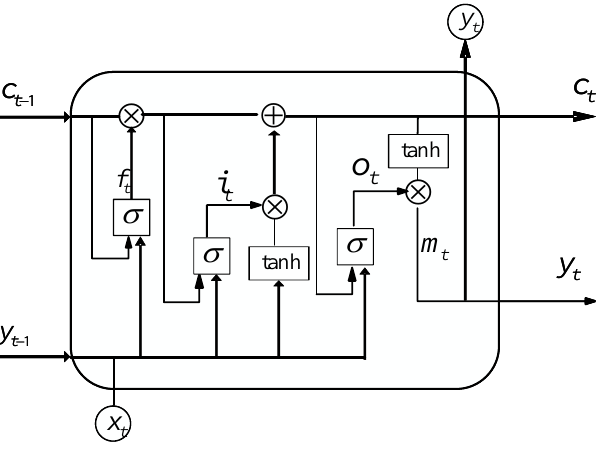
Figure 2. Long short-term memory (LSTM) architecture (a single memory block is shown for